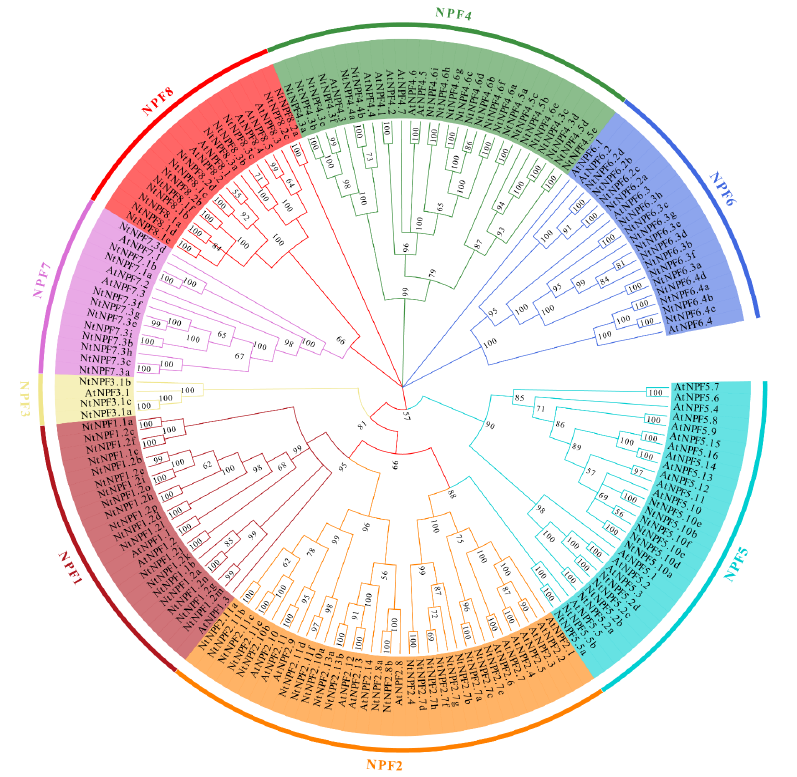
Figure 2. A phylogenetic tree of NPF genes from Arabidopsis and Nicotiana tabacum . The NPF protein sequences were used to generate the phylogenetic tree in MEGA7 with the neighbor-joining method. The bootstrap value was calculated as the percentage of 1000